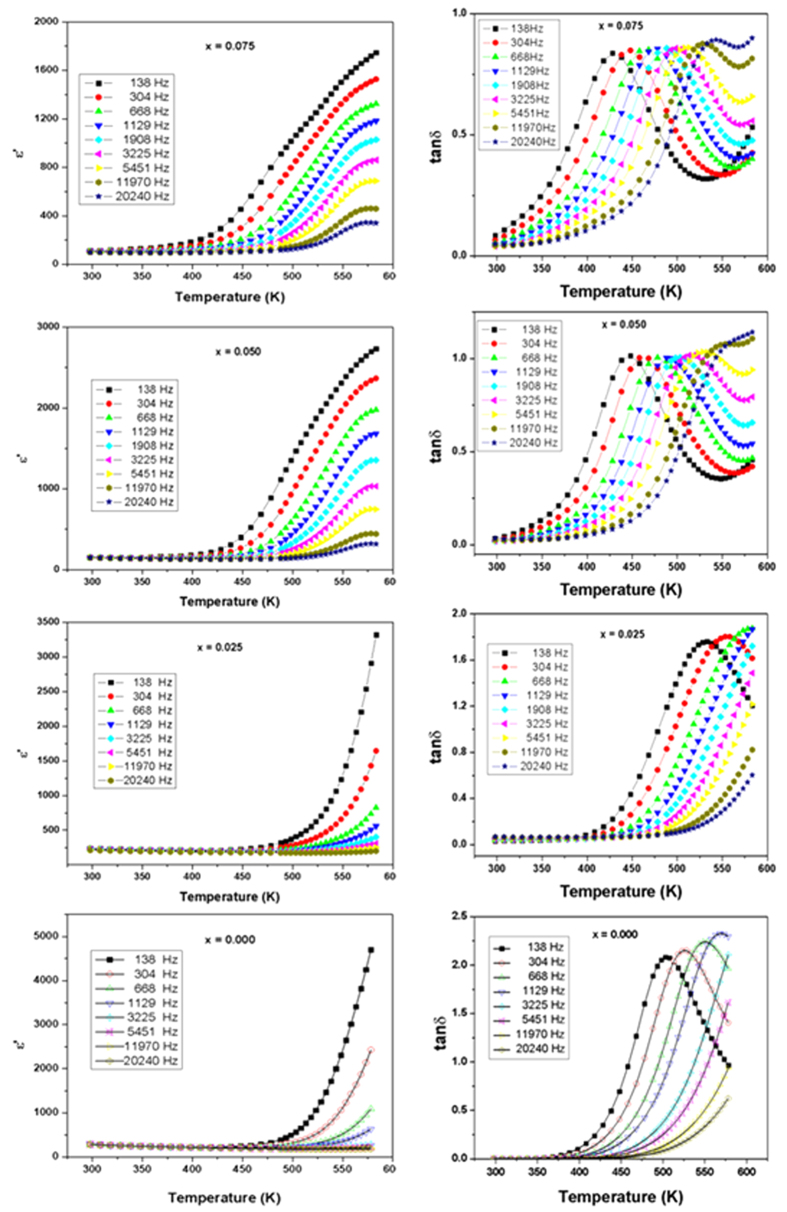
Variation of real part of relative permittivity and tan δ with temperature for cubic solid solution phases in SrTi1−2xFexTaxO3 compositions (x = 0.0, 0.025, 0.050 and 0.075).The solid lines are guide to the eye.